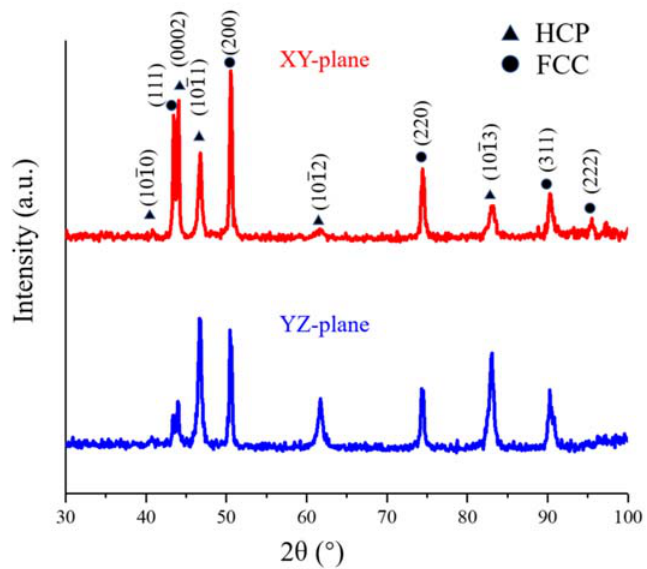
Figure 2. XRD patterns of the different planes of the LMD ‐ produced Fe 50 Mn 30 Co 10 Cr 10 HEA.